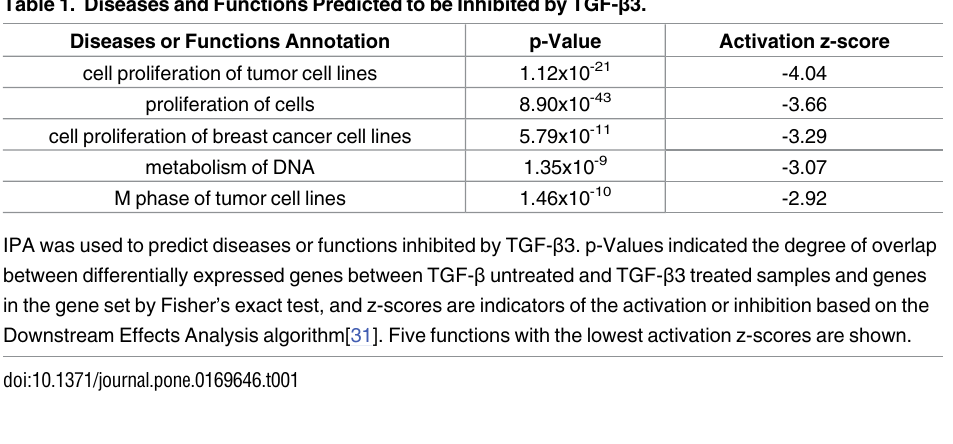
Fig 5. TGF- β 1 and β 3 inhibit various molecules important for B cell function. B cells from two healthy individuals (HC1 and HC2) were culturedfor 48 hours under IL-21 and CD40Lstimulationwith or without TGF- β and transcriptome analysiswas performed by RNA-Seq. (a) Heatmap of genes differentially expressedbetweenTGF- β (-) samples vs. TGF- β 3 samples. (b) MA plot comparing TGF- β (-) samplesvs. TGF- β 3 samples. Differentially expressedgenesare shownin red, and names of selectedgenes are indicated. (c) Heatmap of genesimportant in B cell function.